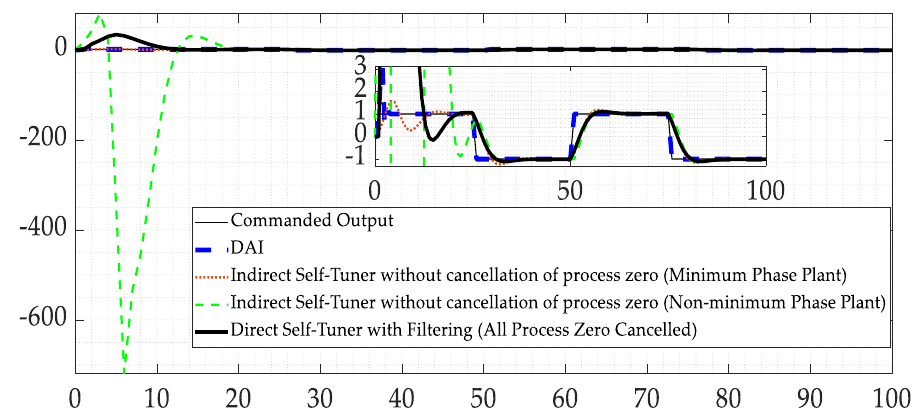
Figure 9. Response comparison with corresponding results in Table 2. The solid (thin) black line is the commanded square wave trajectory. Roughly coincident with this commanded trajectory (after the initial transient) appears the blue-dashed line, representing the response of deterministic artificial intelligence. The red-dotted line represents the indirect self-tuner without process zero cancellation (minimum phase plant). Indirect self-tuner without process zero cancellation (non-minimum phase plant) is represented by the dashed-green line, while the solid (thick)-black line representing direct self-tuner with filtering (all process zeros cancelled).